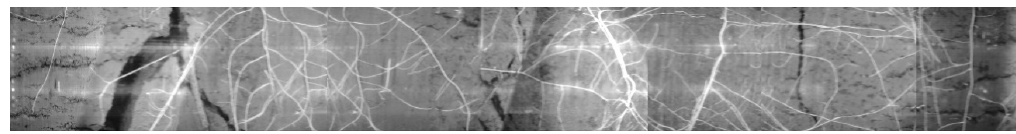
Figure 9. ( a ) Image before processing and ( b ) image after processing (cropped). Sensors 2020 , 20 , 787